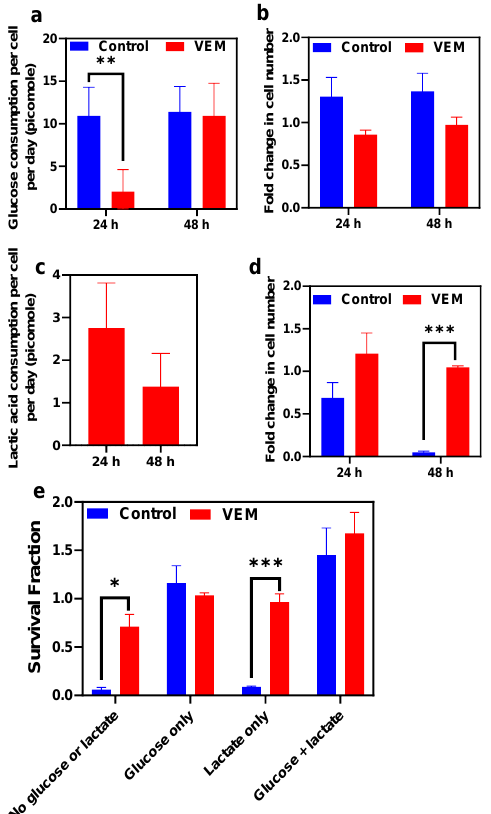
Figure 5. Measurement of glucose and lactic acid consumption. After treatment with VEM, cells were cultured in a minimal medium consisting either glucose or lactic acid. ( a – d ) The substrate consumption rates and live cell numbers were measured for cultures consisting of glucose ( a , b ) or lactic acid ( c , d ) at indicated time points. n = 4. ( e ) Untreated or VEM-treated cells were cultured in various conditions to assess their viability. n = 4. Data points and error bars represent the mean and the standard error, respectively. Statistical comparison was conducted with a pairwise t -test (* p < 0.5, ** p < 0.01, and *** p < 0.001).